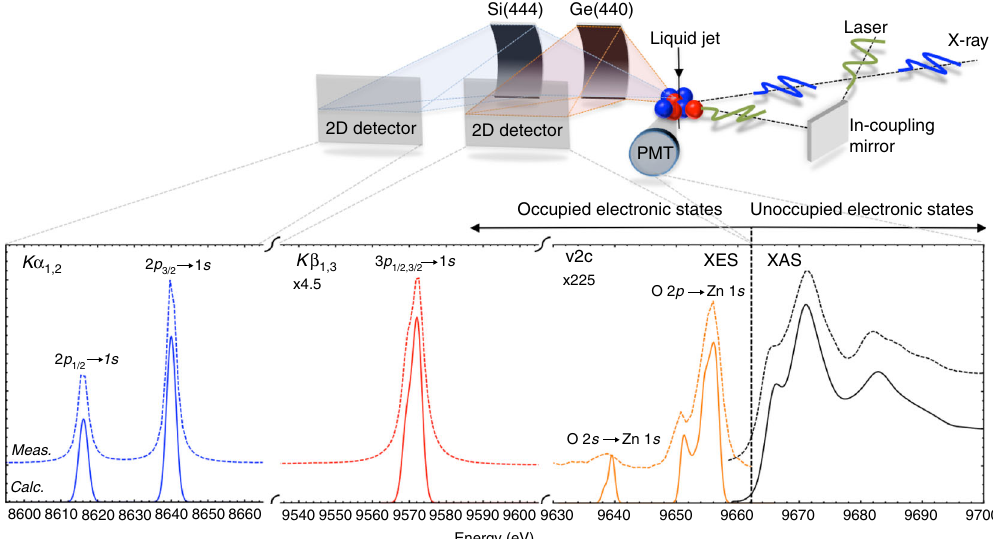
Fig. 1 Experimental Setup. Upper panel shows: Schematic of the experimental setup used herein, with the two-crystal von Hamos XES spectrometer and scintillator/photomultiplier tube (PMT). The signals measured by the various components are shown adjacent to the detectors. Lower panel shows: The ground state Zn K-edge XAS, K α , K β and valence to core spectrum (dashed lines) and corresponding simulations (solid